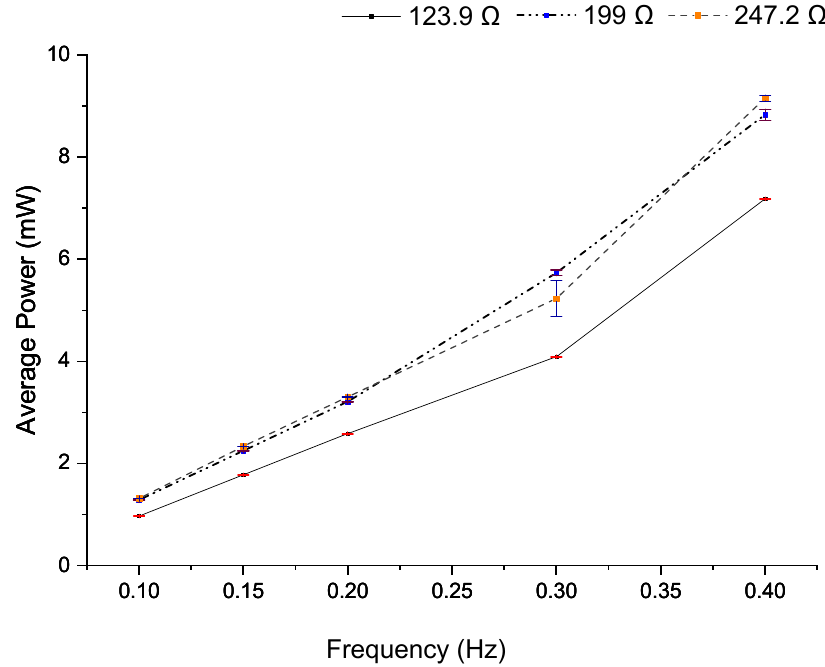
Figure 13. Average output power was measured in three different load resistance values, with movement frequency from 0.1 to 0.4 Hz. Mean values (dots) and mean ± standard deviation .